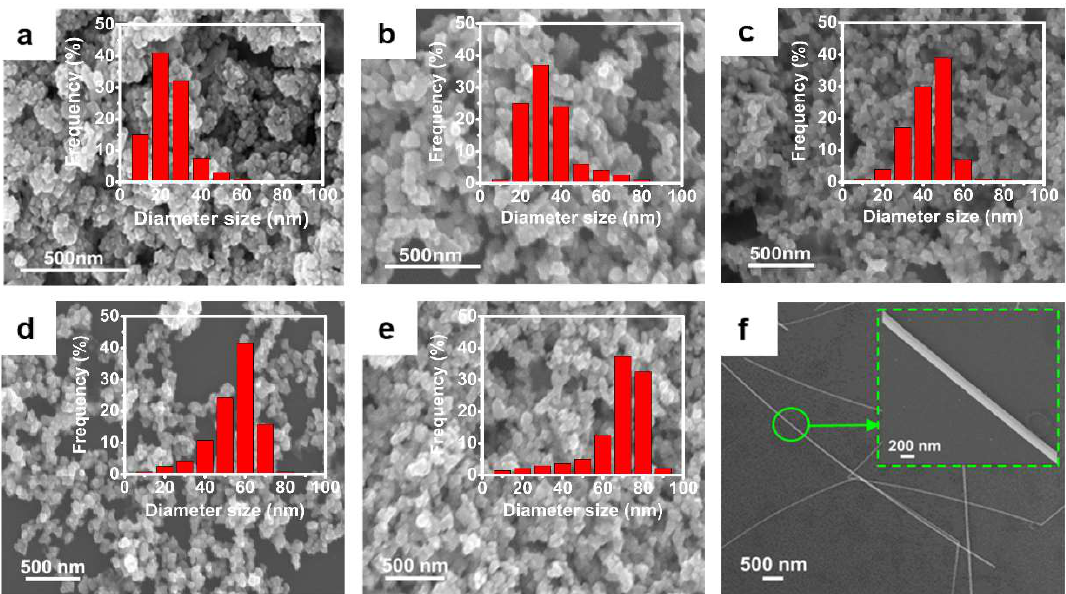
Figure 3. ( a – e ) Scanning electron microscopy (SEM) images of the Ag NP that synthesized at w = 3, 5, 8, 10 and 15, respectively. The inserts show the size distributions, which were measured by dynamic light scattering (DLS) in ethanol based on intensity and had been normalized to a frequency of size distribution. ( f ) SEM image of the Ag NW that synthesized at w = 25. In all six experiments, the mass fractions of AOT are 2%.